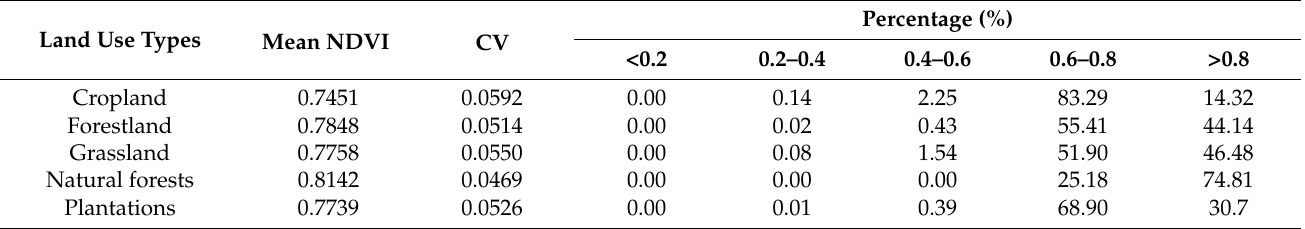
Table 3. Statistical variation of NDVI of different vegetation types and its variation coefficient of interannual variation in the MRYR from 1999 to 2015.